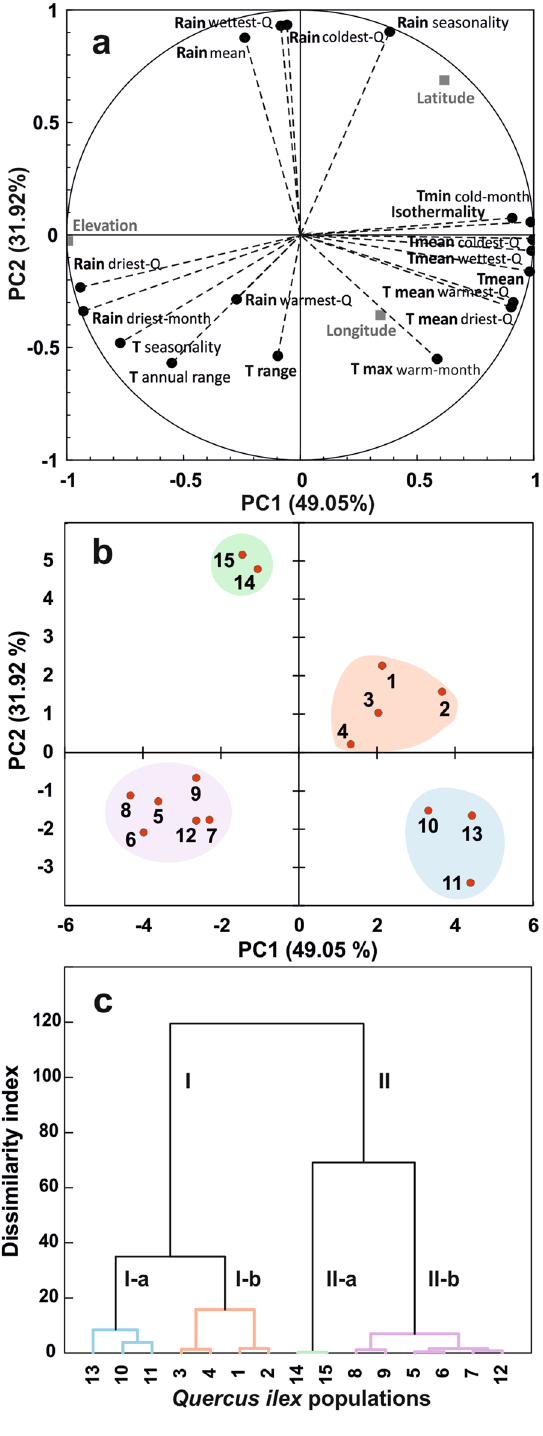
Fig. 2 Multivariate analysis of the climatic characteristics of the 15 Quercus ilex sampling sites. a Principal Component Analysis (PCA) correlations (factor loadings) of climatic variables with the first two principal components (PC). Longitude, latitude and elevation, in grey, were treated as supplementary variables. b PC1–PC2 score plot of the 15 populations studied. Each population sampled was characterized by its factorial score co‑ordinates on the first two PCs. c Hierarchical Ascendant Classification (HCA) of holm oak sites according to their climatic variables. HCA analysis revealed 4 differentiated clusters, which colour code have been reported on the upper PC1‑PC2 score